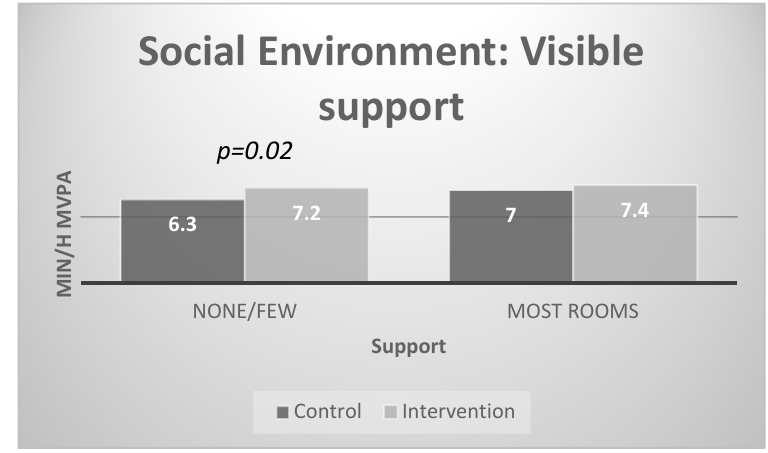
Figure 2. Interaction effects with visible support for physical activity. Int. J. Environ. Res. Public Health 2019 , 16 , x